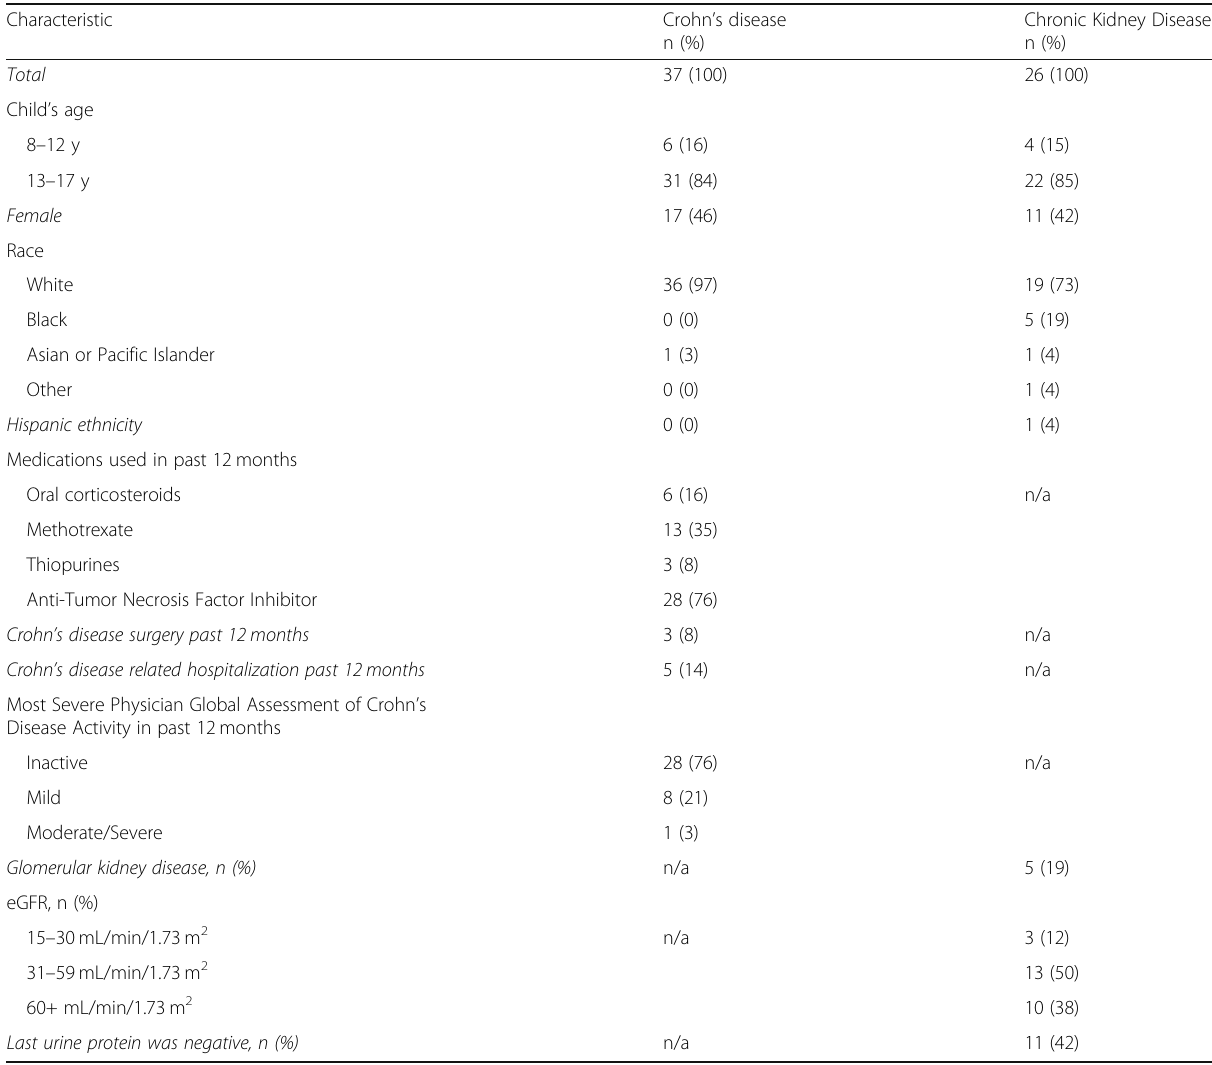
Table 1 Participant Demographic and Clinical